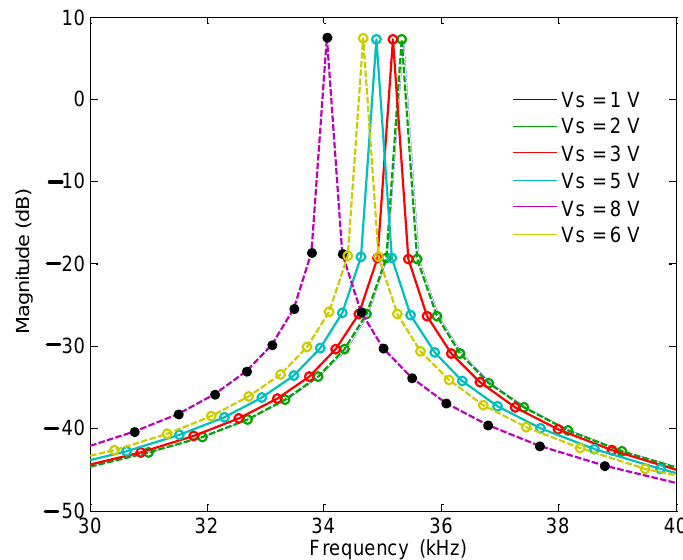
Figure 17. Amplitude frequency curve (double-stage beam).